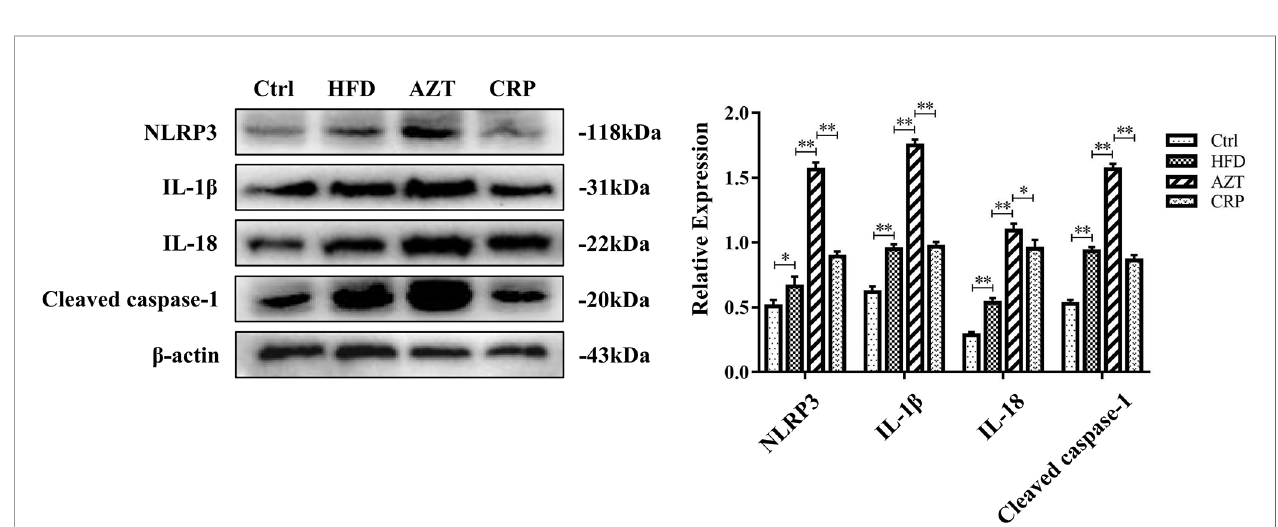
FIGURE 6 | Expression levels of liver NLRP3/caspase-1 signalling pathway-related proteins and grey value analysis between the groups. Differences were assessed by ANOVA. Data are expressed as the mean ± SEM, *P < 0.05, **P < 0.01.